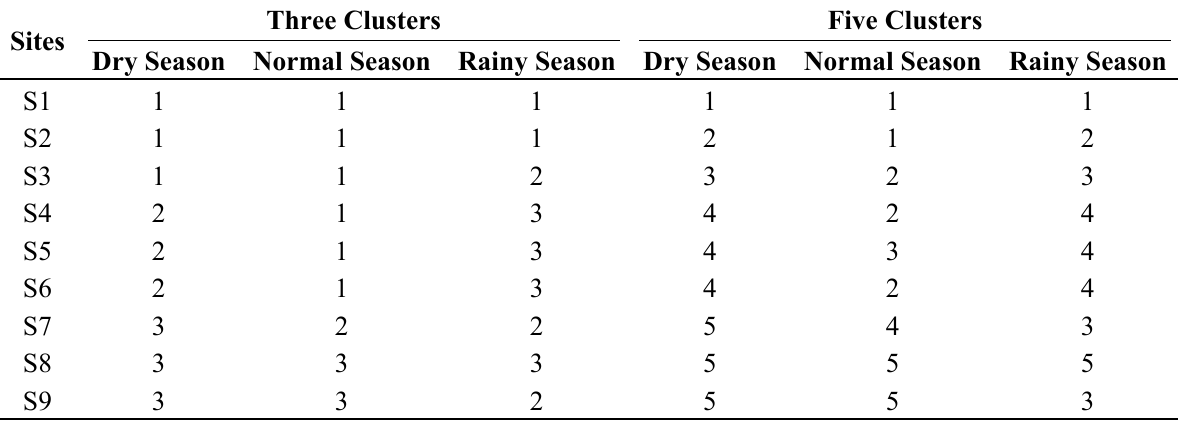
Table 2. Site grouping according to Q-style Cluster Analysis (CA) based on Dataset1 (The sites with the same number were gathered into the same